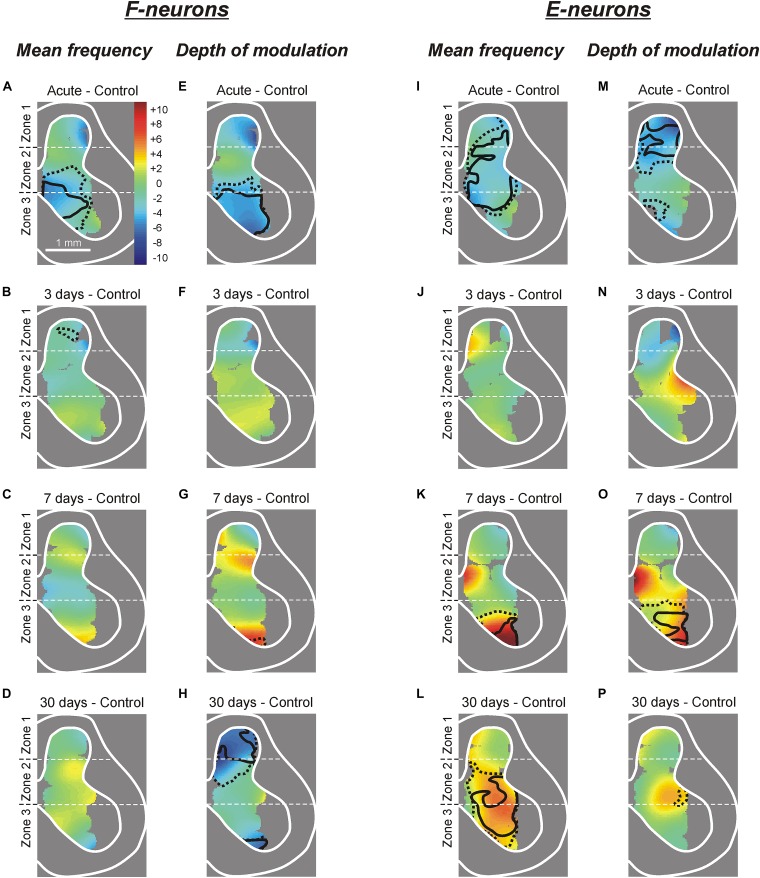
Changes in the mean frequency and in the depth of modulation of local populations of F- and E-neurons at different time points after spinalization. The difference between the averaged distribution of the mean frequency (A–D,I–L) and of the depth of modulation (E–H,M–P) of F-neurons (A–H) and E-neurons (I–P) on the cross-section of the spinal cord at a particular time point after spinalization and the corresponding distribution in control (subtraction of Control from corresponding spinal). Averaged distributions of the mean frequency and depth of modulation for F- and E-neurons in control, after acute spinalization, as well as on 3rd, 7th, and 30th day after spinalization are presented as heatmaps in Supplementary Figure S1.